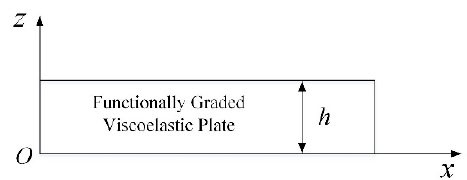
Figure 1. Functionally graded viscoelastic film and coordinate system.